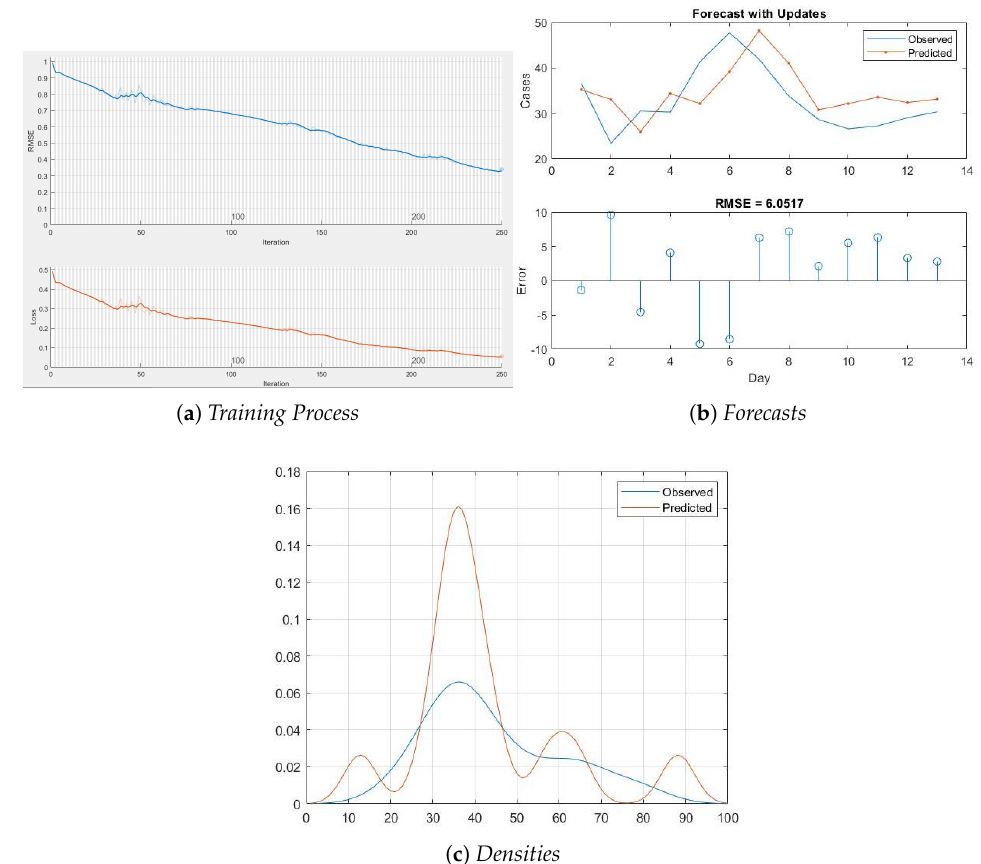
Figure 17. Summary of the results of long-term short-term memory (LSTM) network on one year data for two weeks forecast.